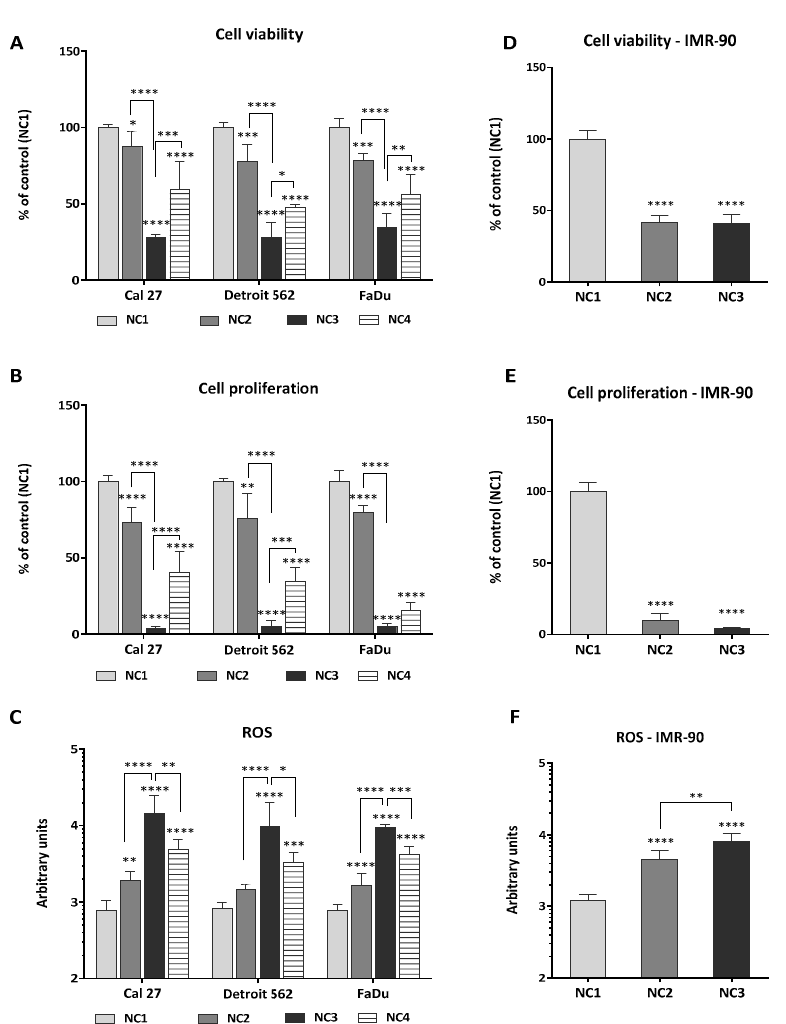
Figure 2. The viability, proliferation and generation of ROS in cancer cell lines ( A – C ) and IMR-90 ( D – F ) after exposure to NC1-NC4 and NC1-NC3, respectively, for 48 hours. One-way ANOVA